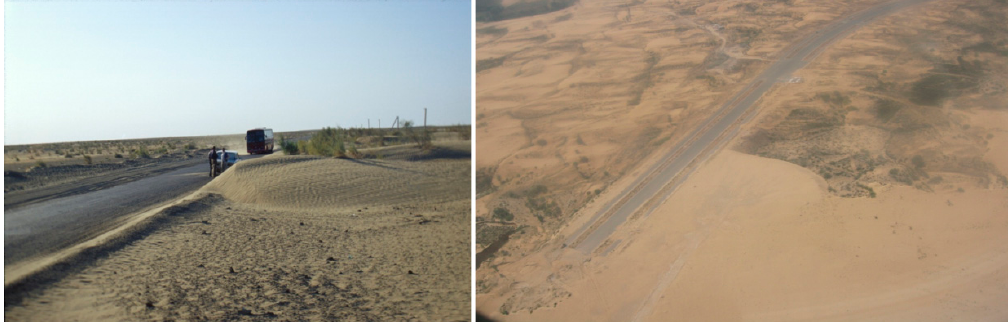
Figure 5. Sanding up of traffic lanes, here: Kyzyl Kum transit road, 120 km north of Bukhara, Uzbekistan (photo: Ch. Opp ).